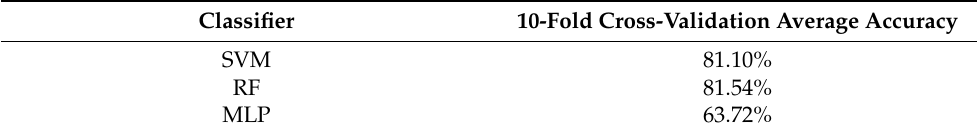
Table 3. The 10-fold cross-validation results of the proposed three classification